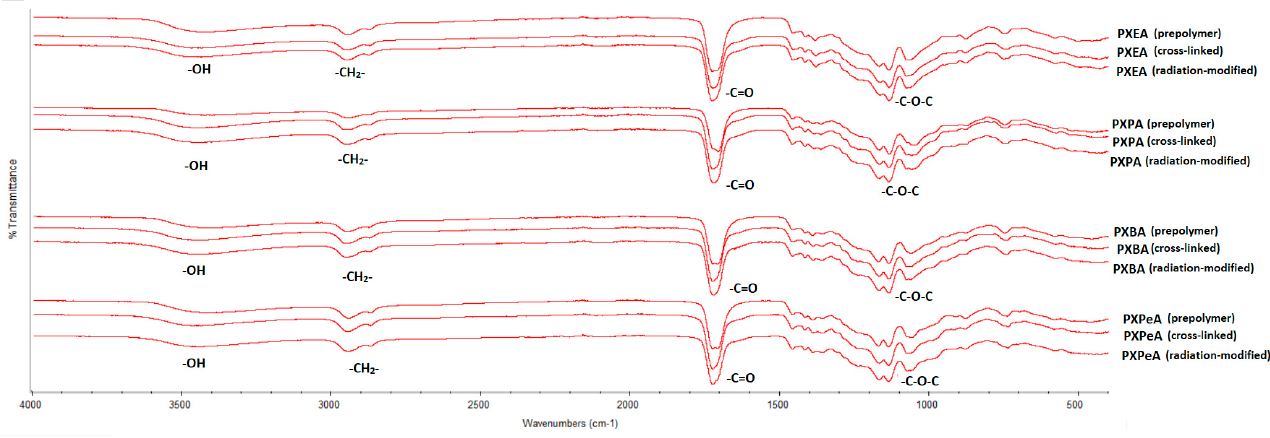
Figure 7. FTIR spectra of PXEA, PXPA, PXBA, and PXPeA prepolymers, polymer crosslinked, and polymer after radiation modified.